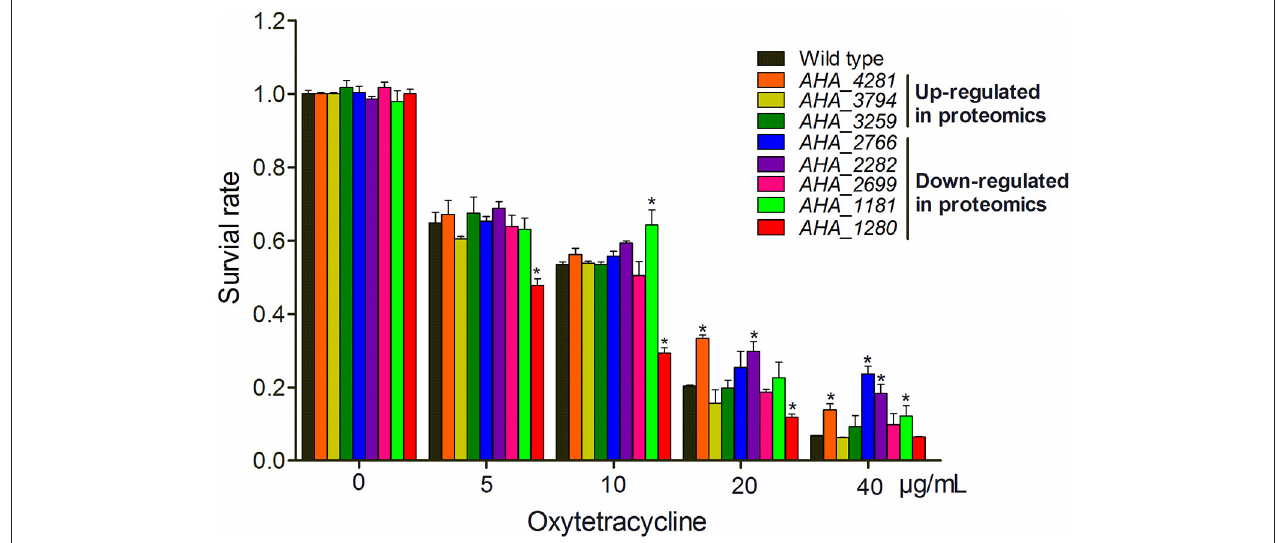
FIGURE 5 | Histograms displaying survival capabilities of selected mutants upon OXY stress. The survival capabilities of eight mutants, including 1 AHA_1181 , 1 AHA_2282 , 1 AHA_3794 , 1 AHA_4281 , 1 AHA_1280 , 1 AHA_3259 , 1 AHA_2699 , and 1 AHA_2766 were calculated under OXY treatment of different concentrations (0, 5, 10, 20, and 40 µ g/mL). * P < 0.05.